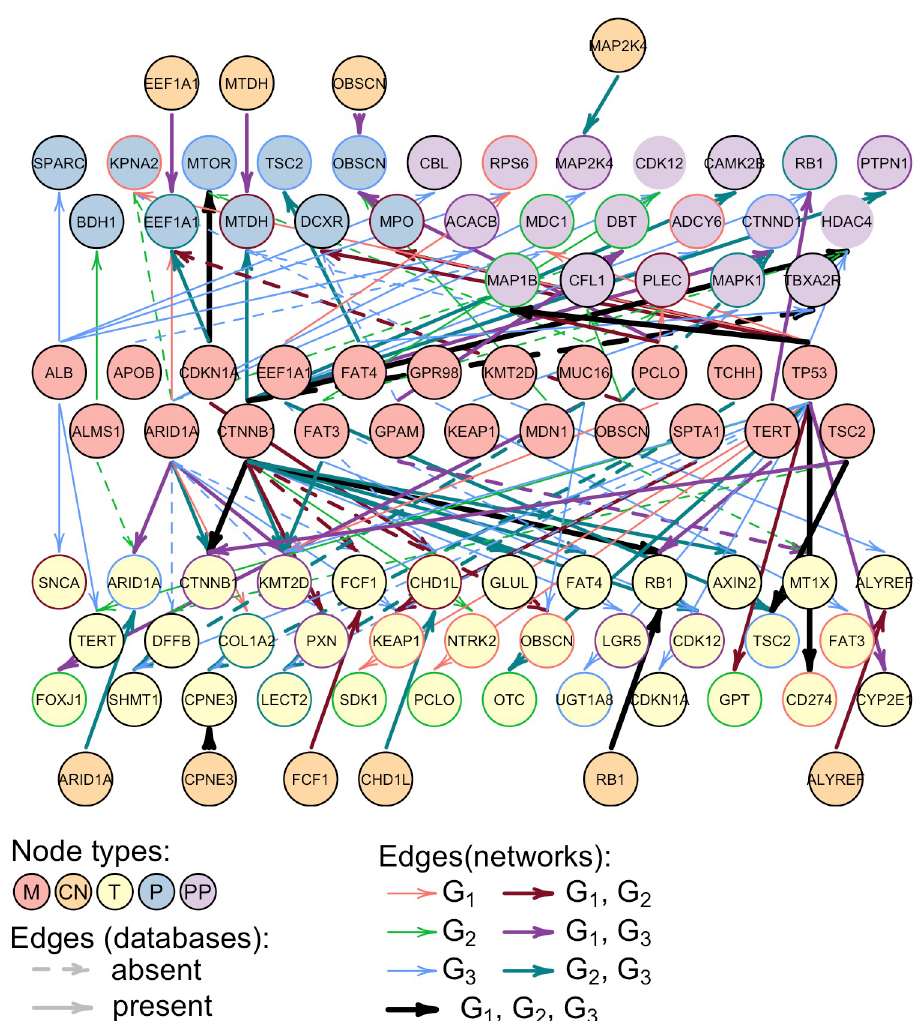
Fig 5. Mutated genes and their most common interaction partners in HCC networks learned by bnClustOmics. Only those T , P , and PP nodes are shown that are differentially expressed/phosphorylated in at least one cluster or the whole dataset. Edges are shown based on their posterior probability: either if they have a high total posterior probability (sum across clusters is at least 1.2), or if they have a high posterior probability in at least one of the clusters ( p > 0.9). Edge colors indicate in which cluster-specific networks the edges are present with a posterior probability p > 0.4: red( G 1 ), green( G 2 ), blue ( G 3 ), brown ( G 1 and G 2 ), violet ( G 1 and G 3 ), turquoise ( G 2 and G 3 ), black ( G 1 and G 2 and G 3 ). Border colors of T , P , and PP nodes represent the differential expression status (color scheme is the same as edge colors). Solid edges denote either connections between two omics types of the same gene or interactions found in the STRING and Omnipath